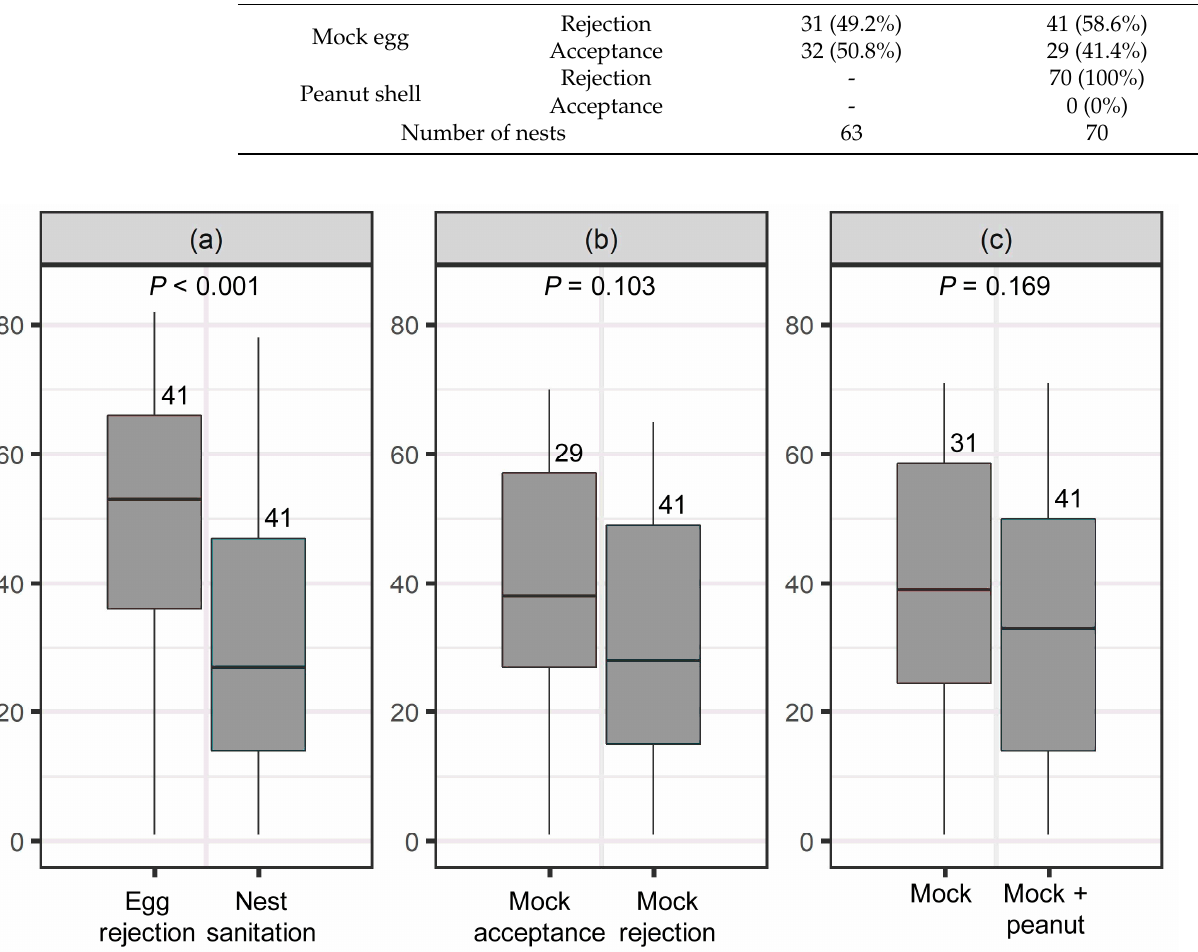
Table 1. Probability of mock egg rejection and/or nest sanitation in the mock egg trial (mock) and